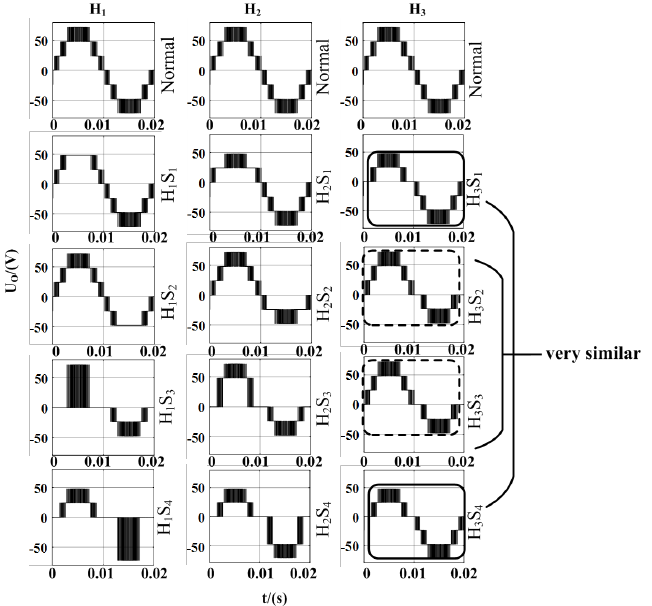
Figure 4. Fault signals of CHMI with load = 5 Ω when an Open Circuit (OC) occurs at 0 s and m = 3.